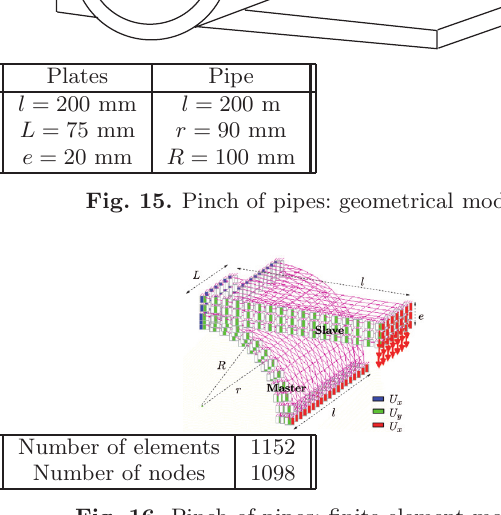
Fig. 16. Pinch of pipes: finite element model.